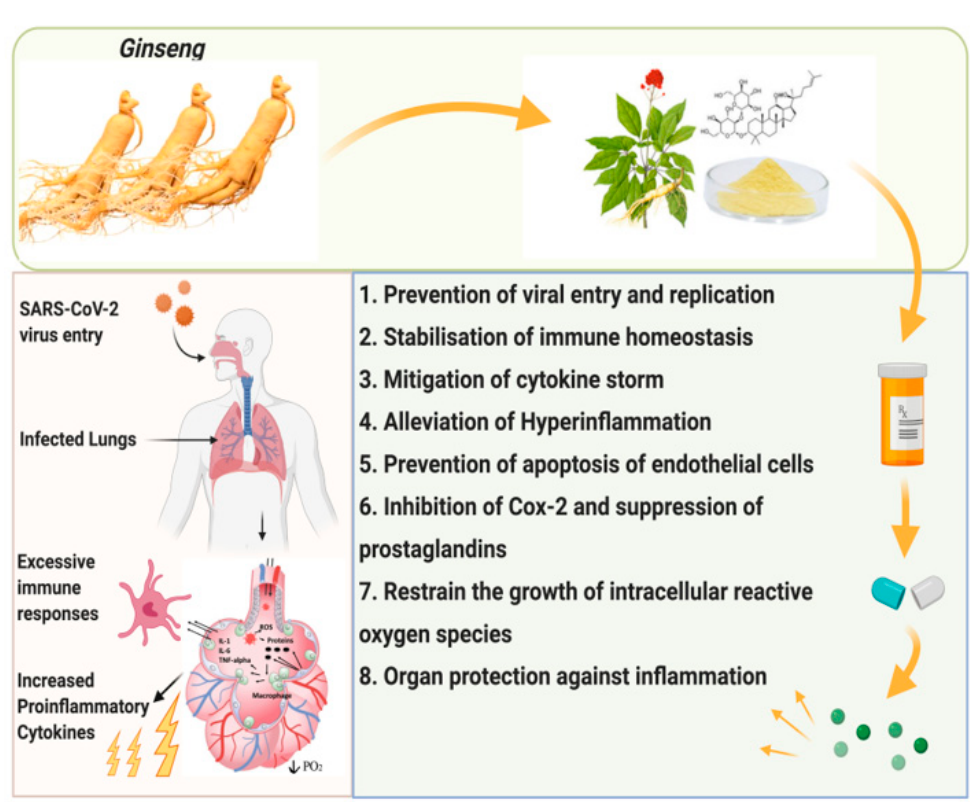
Figure 5. Probable role of Ginseng for coronavirus.